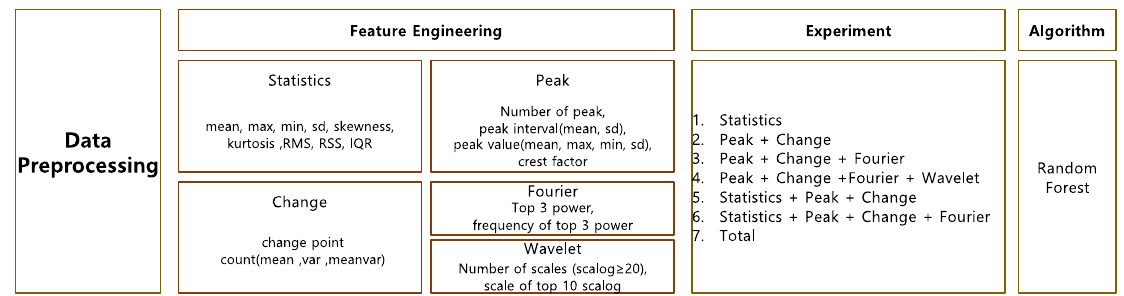
9 of 19 Table 2. Details of the feature set. Category Features Top 3 power 6 Frequency of top 3 power Wavelet Top 10 scales with high scalog values 10 Total